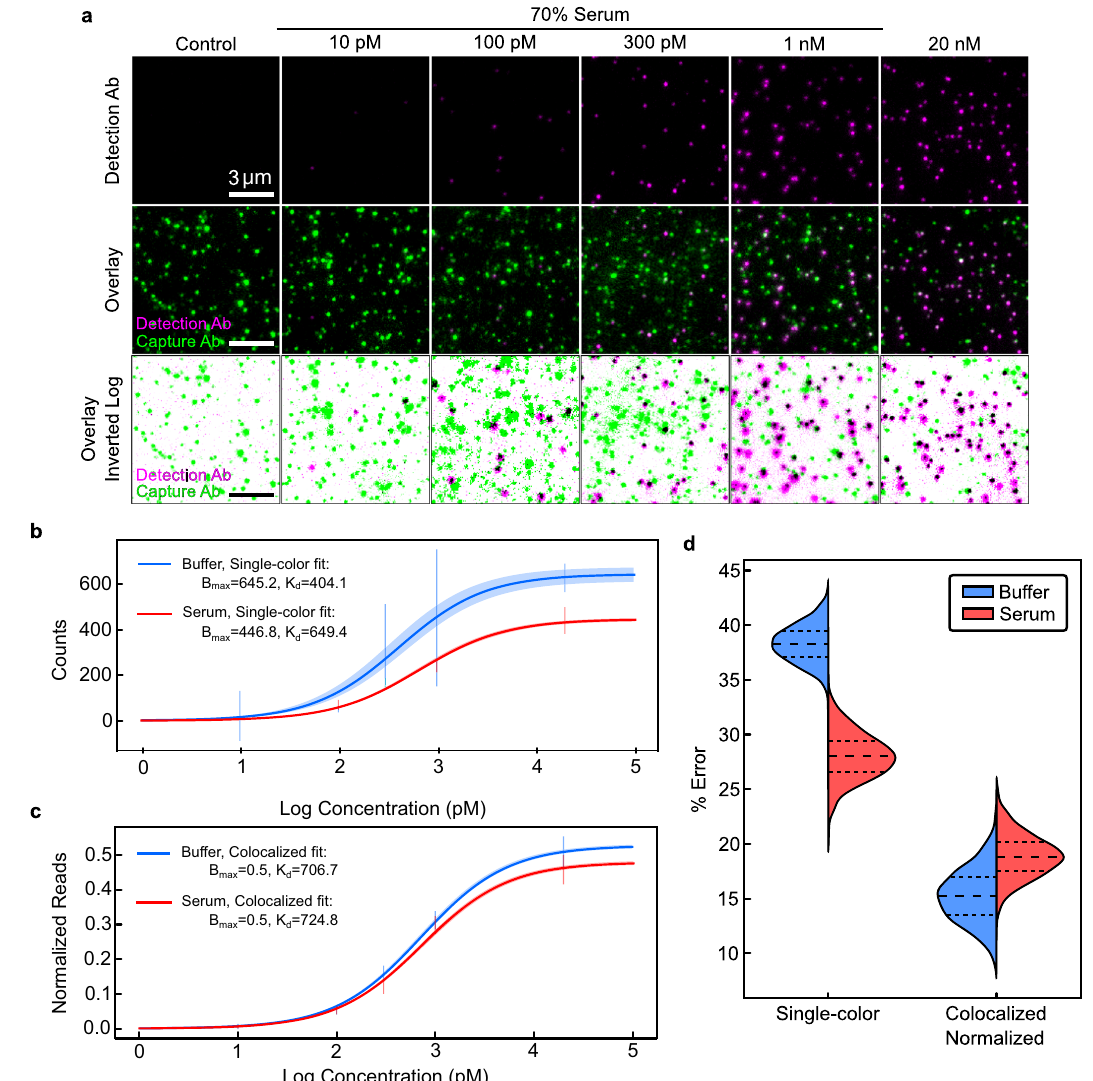
Fig. 3 | Quanti fi cation of TNF- α via single- and two-color analysis in buffer and 70% chicken serum. a Single-color (top) and colocalized (middle, bottom) signal for increasing concentrations of TNF- α spiked into 70% chicken serum with 50nM dAb.Best- fi tTNF- α binding curves for( b ) absolute dAbcounts and ( c ) normalized, colocalized counts in buffer and 70% chicken serum. 2 σ con fi dence curves are